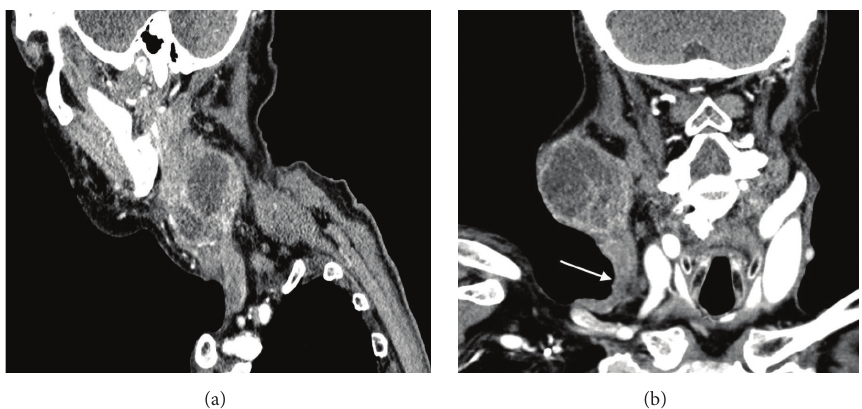
Figure 2: CT neck: sagittal and coronal images with contrast demonstrating parotid tumor with external jugular vein invasion with extension to the level of the right subclavian vein.